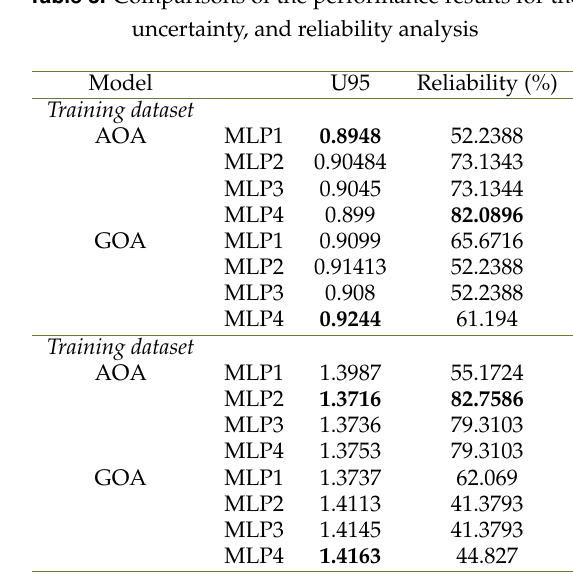
Table 3. Comparisons of the performance results for